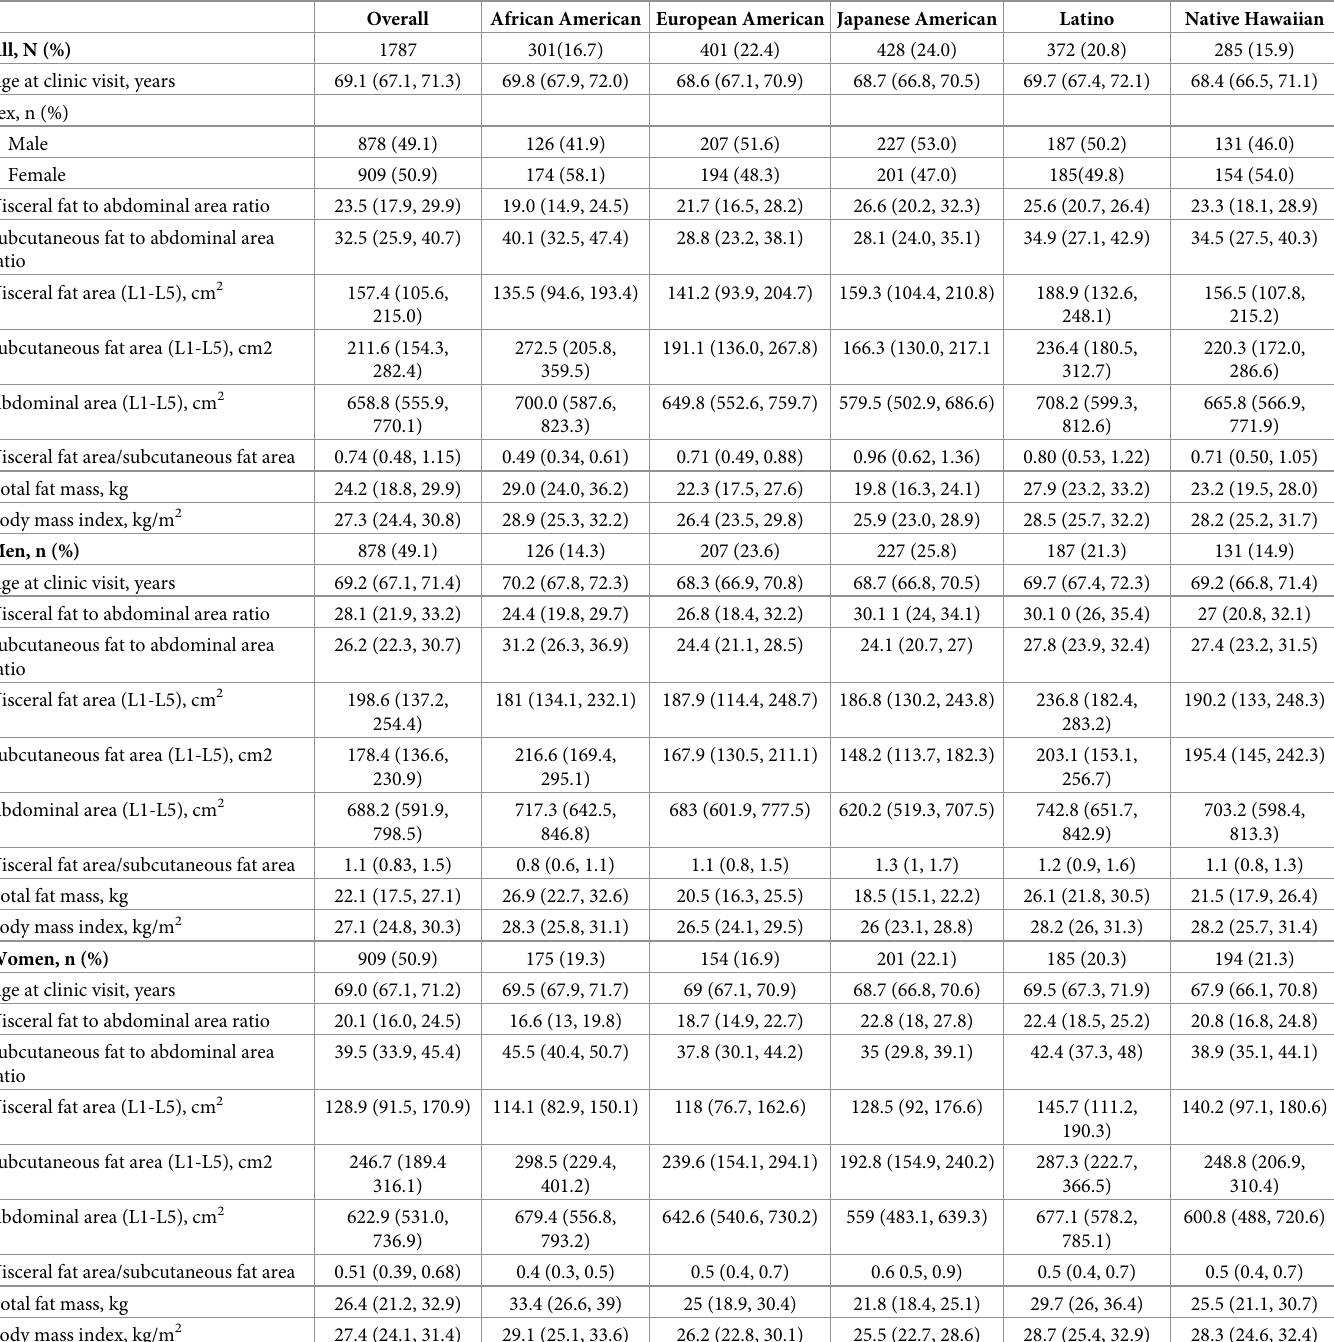
Table 1. Descriptive characteristics of MEC-APS subjects with valid visceral fat area and genotyping values, overall and by race/ethnicity (N = 1787) a .